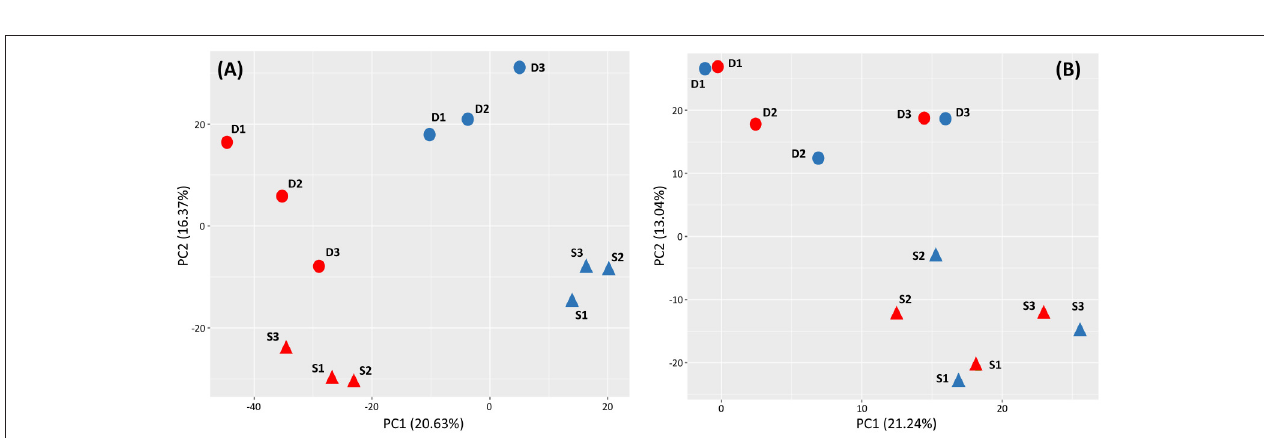
FIGURE 1 | Maximum PSII photochemical efficiency (F v /F m ) of shallow and deep Posidonia oceanica plants from the control and heat treatments at the end of the heat exposure (A) and recovery (B) periods. Averaged F v /F m values ( ± standard error) of the three shoots measured in each individual genotype (empty symbols) and the average value of the three replicate genotypes (solid symbols) are represented. Plant’s depth is represented with different symbols as showed in the legend.